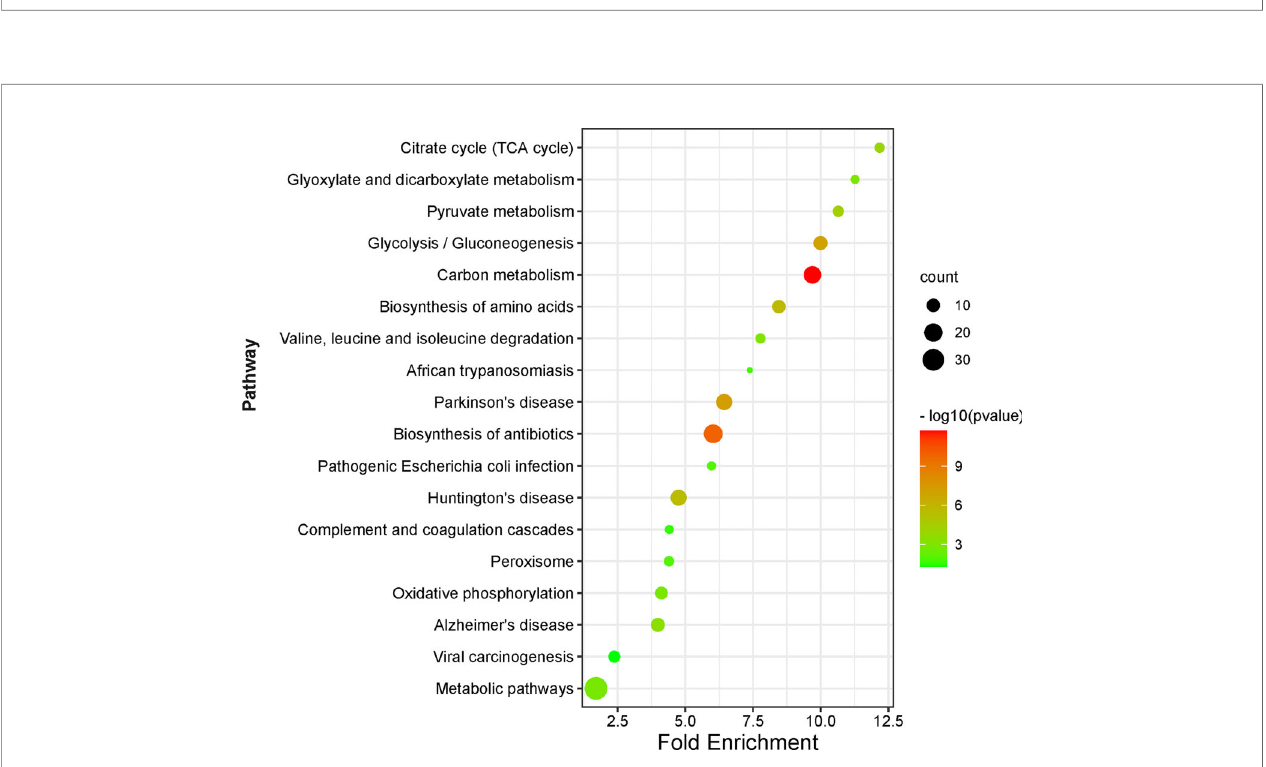
FIGURE 7 | KEGG pathway enrichment analysis of DAPs between NF-PitNETs and the controls. The Y axis shows different pathway terms, the X axis shows fold Genehits Genepathway = enrichment. Fold enrichment is calculated as followed: Hitstotal Genetotal = . Genehits represents the number of hits in the selected pathway; Genepathway represents the number of genes in the selected pathway of KEGG background; Hitstotal is the number of total hits in all pathways; Genetotal means the number of total genes in all pathways of KEGG background. The circle size represents the count of genes enriched on the pathway. The circle color shows the -log10(p value) of the pathway.